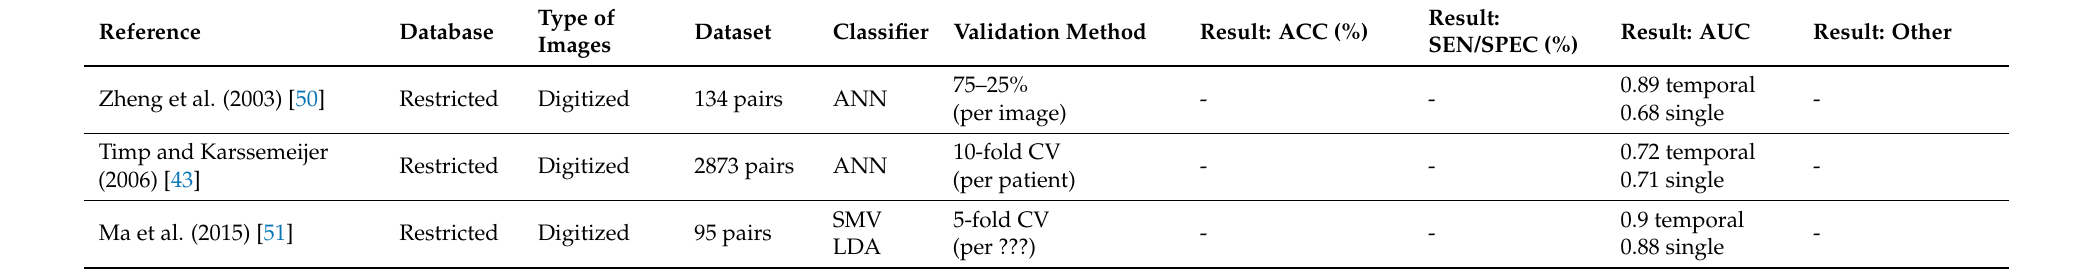
Table 2. Comparison of algorithms for the detection of masses in sequential mammograms using temporal analysis and feature-based machine learning.